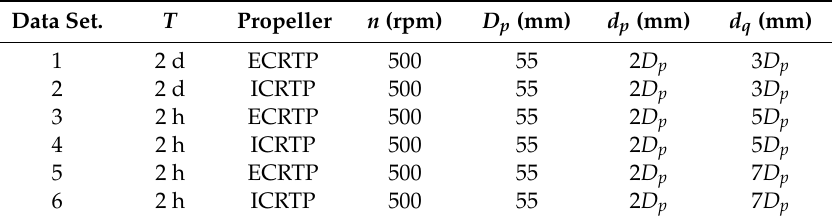
Table 1. Scouring test of quay